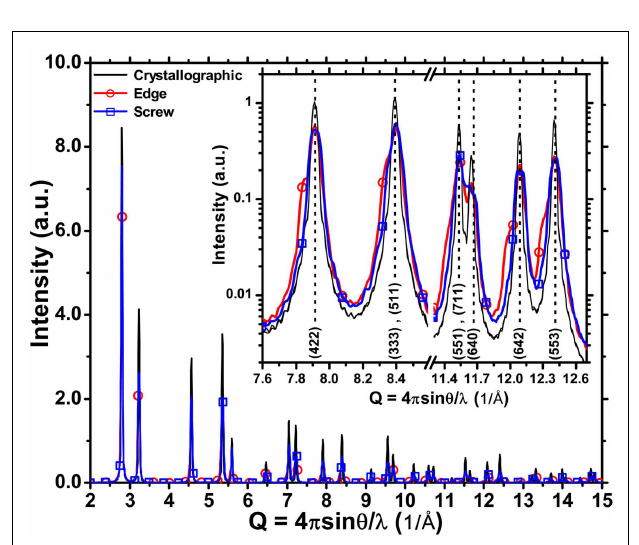
FIGURE 5 | X-ray powder diffraction pattern simulated by DSE from the time averaged microstructure of cylindrical Pd nanocrystals ( D = H = 16nm) with edge (red circular dot), screw (blue square dot) dislocations, and from the corresponding ideally perfect (“crystallographic”) nanocrystals (black) .